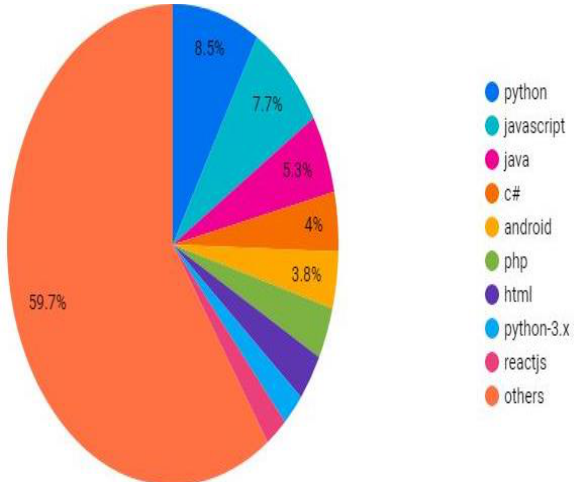
Figure 4. Pie chart for Top 100 Tags and frequencies between (2018-2019).